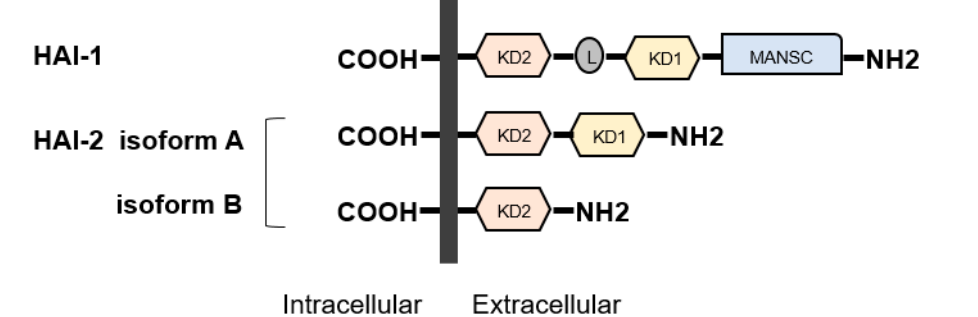
Figure 3. Structures of hepatocyte growth factor activator inhibitor (HAI)-1 and HAI-2 are shown. HAIs show single-pass transmembrane protein with intracellular carboxy-terminus and extracellular specific protease inhibitor domains, the so-called Kunitz domain (KD). HAI-1 is composed of two KDs, L domain, and motif at N terminus with seven cysteines (MANSC) domains. There are two isoforms in HAI-2. Similar to HAI1, HAI-2 isoform A has two KDs, whereas isoform B has a single KD.